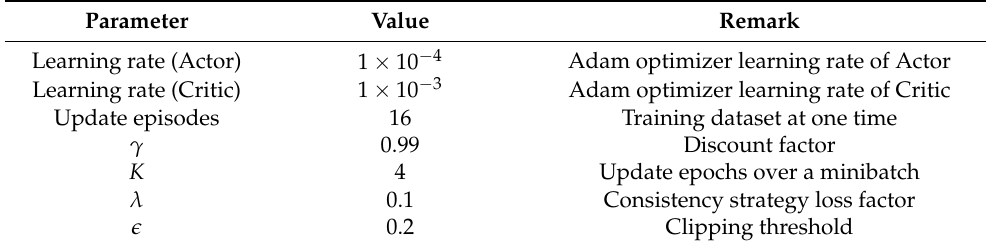
Table 1. Reinforcement learning parameter settings.